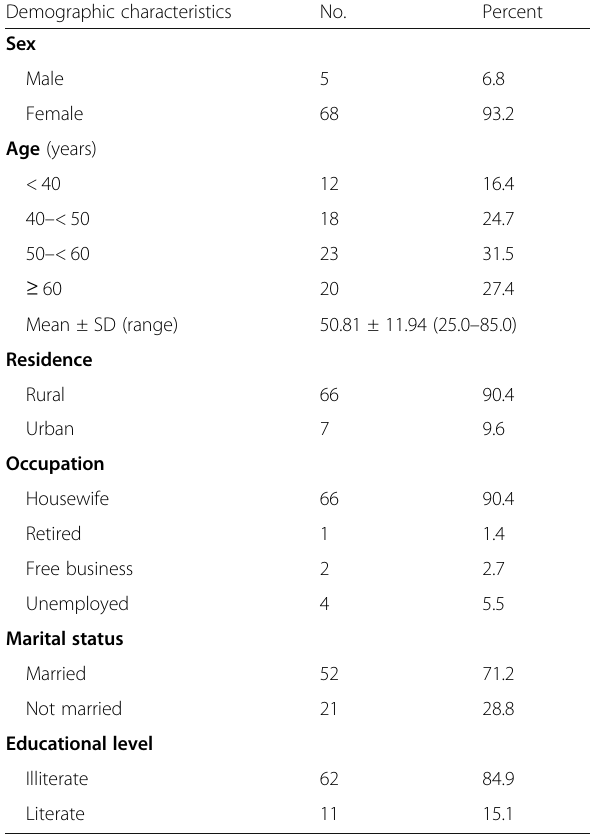
Table 1 Demographic characteristics of the studied